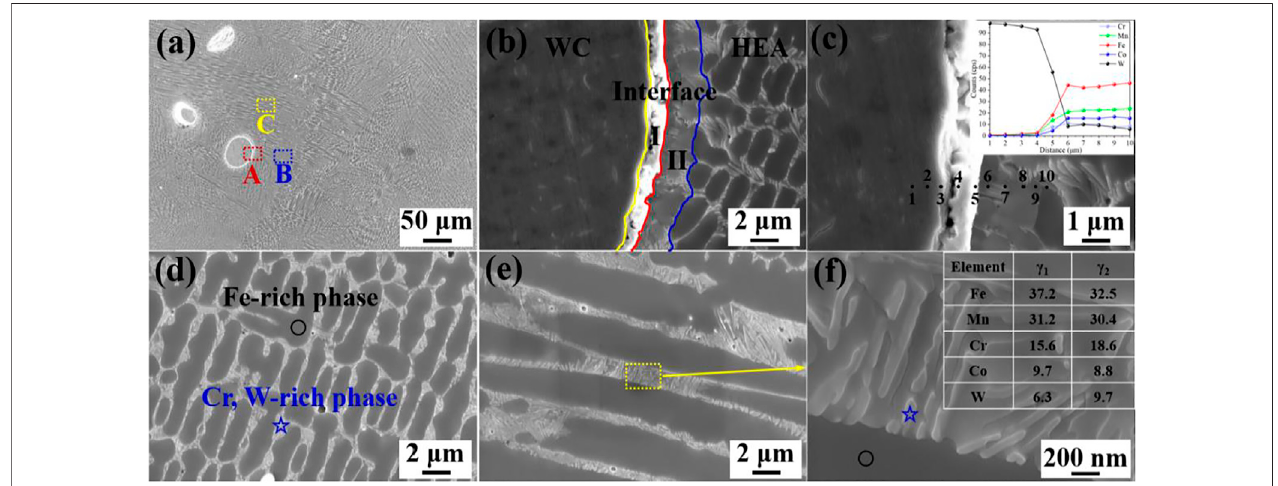
FIGURE6 | SEMimageand the corresponding elemental compositionofthe 10 – 2sample. (A) sketch maps ofdifferentmorphologies; (B,C) magni fi ed image ofA region in the (A) and points' elemental composition; (D) magni fi ed image of B region in the (A) ; (E,F) magni fi ed image of C region in the (A) and points' elemental composition.